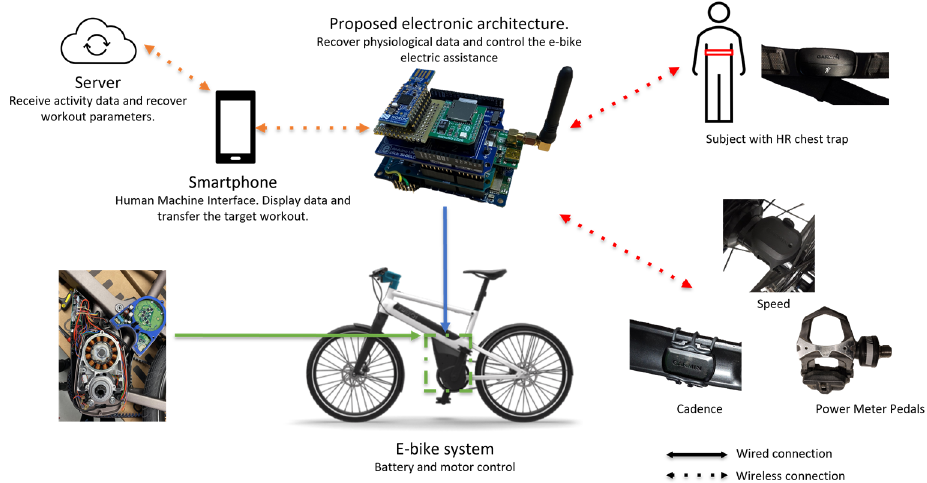
Figure 1. Prototype electronic architecture and its environment.